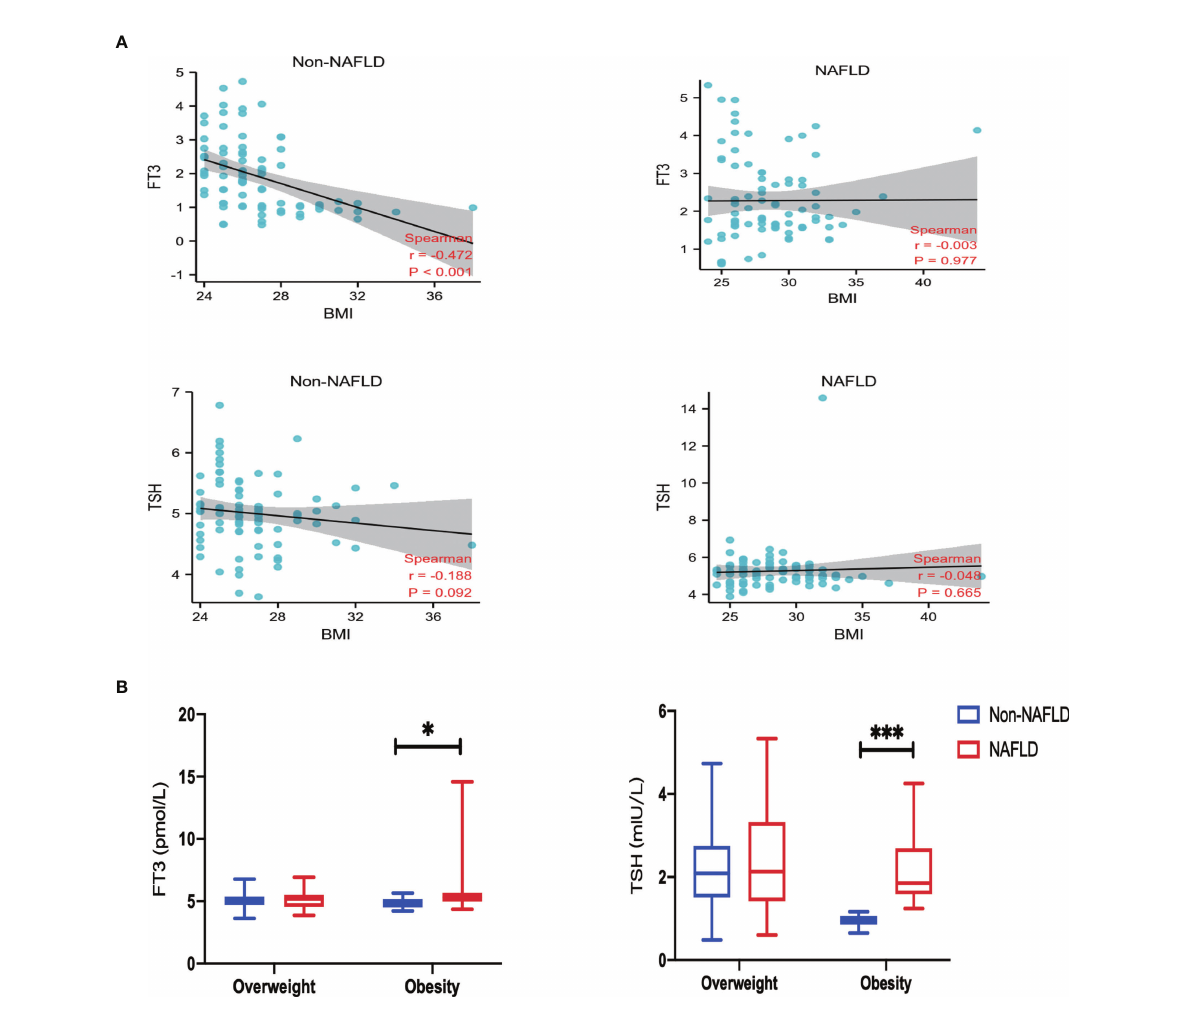
FIGURE 2 Correlation and Subgroup analysis. (A) Spearman correlation analysis of body mass index (BMI), free triiodothyronine (FT3) and thyroid- stimulating hormone (TSH). (B) Comparison of FT3 and TSH among groups classi fi ed according to BMI. Values are represented as mean ± SD. *p < 0.05, ***p < 0.001 vs. the Non-NAFLD